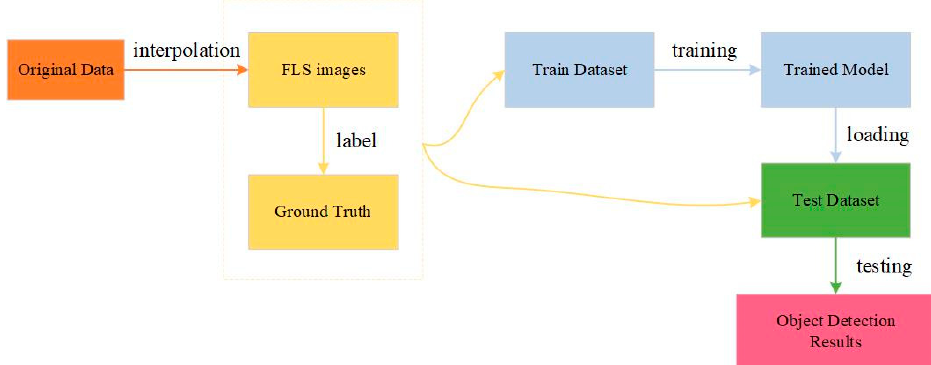
Figure 9. An illustration of training and testing of networks in our experiment.